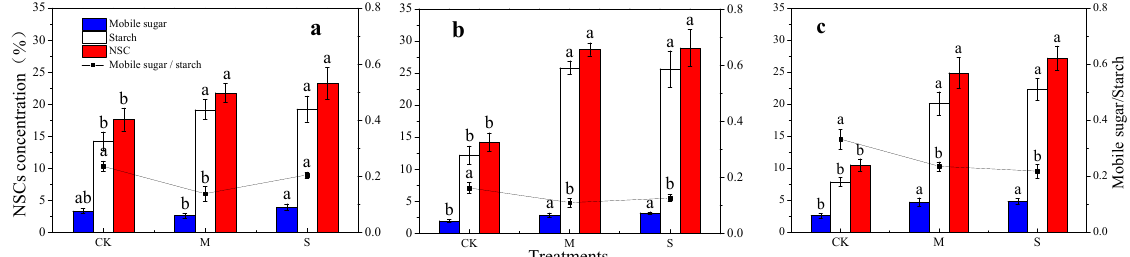
Figure 6. Effects of drought stress on the concentrations and composition of NSCs in bamboo roots. The different lowercase letters denote significant differences between treatments ( p < 0.05). The histograms represent starch, mobile sugars or NSC, and the line charts represent the ratio of mobile sugars to starch. ( a ): 30th day; ( b ): 60th day; ( c ): 90th day. NSCs: non-structural carbohydrates.